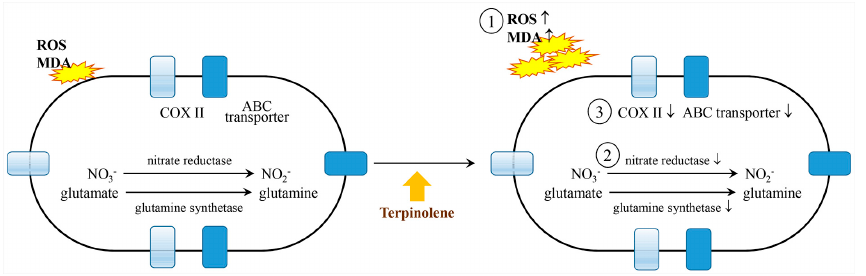
Figure 12. Terpinolene blocks the propagation of Microcystis aeruginosa through ○ 1 ROS and MDA- induced photosynthetic inactivity, ○ 2 inhibiting the activity of nitrate reductase and glutamine synthetase, and ○ 3 increasing the efficacies of ABC transporters and COX II in the plasma membrane (modified from Zhao et al. 2020 [115]). Reactive oxygen species, ROS; malondialdehyde, MDA; nitrate reductase, NR; glutamine synthetase, GS; ATP-binding cassette transporters, ABC transporter; cytochrome c oxidase subunit II, COX II. ↑ : increasing; ↓ : decreasing